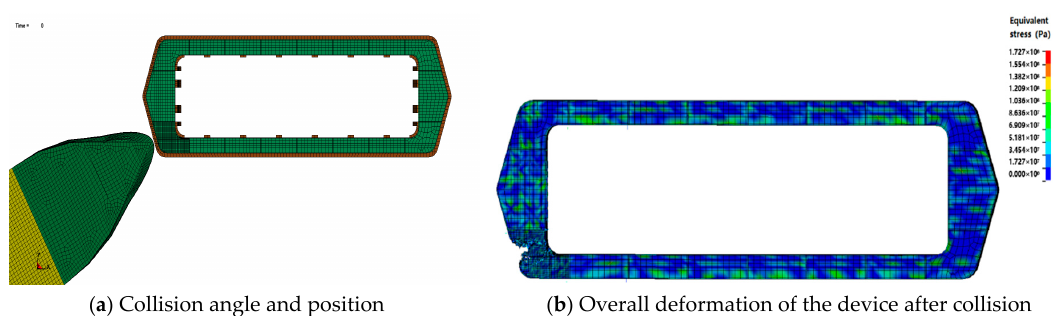
Figure 31. 30 ◦ collision when the ship collides with the collision avoidance device.